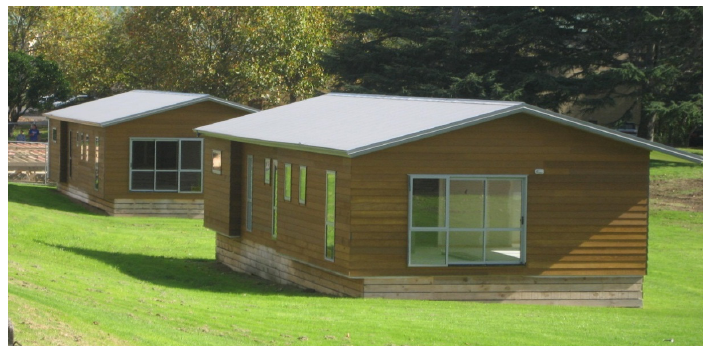
Figure 4. Control house (foreground) and test